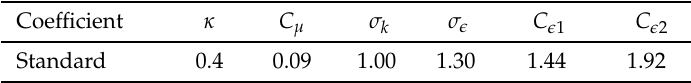
Table 1. A set of typical coefficients of the k − (cid:101) model. [16].